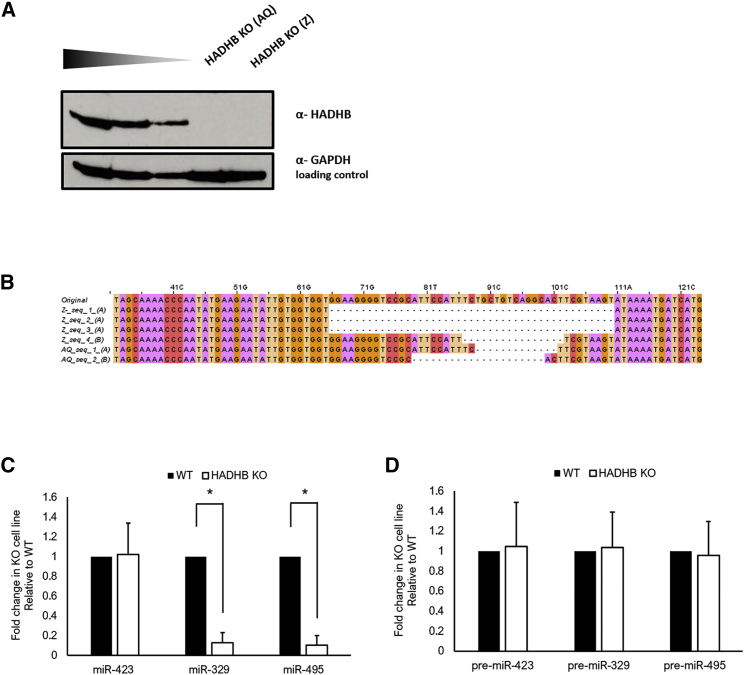
Generation of NIH 3T3 HADHB KO Cell Lines by CRISPR/Cas9(A) Western blot analysis of HADHB protein levels in two HADHB KO clones (AQ and Z) compared with decreasing amounts of total protein extract from WT NIH 3T3 cells. (B) Alignment of the region surrounding the CRISPR-Cas9 target sequence from genomic DNA of clones AQ and Z. (C and D) Levels of mature (C) or precursor (D) miR-329 and miR-495 as well as control miR-423 in WT and HADHB KO cell lines quantified by qRT-PCR and normalized to miR-16. For pre-miRs, n = 3; for mature miRs, n = 9.